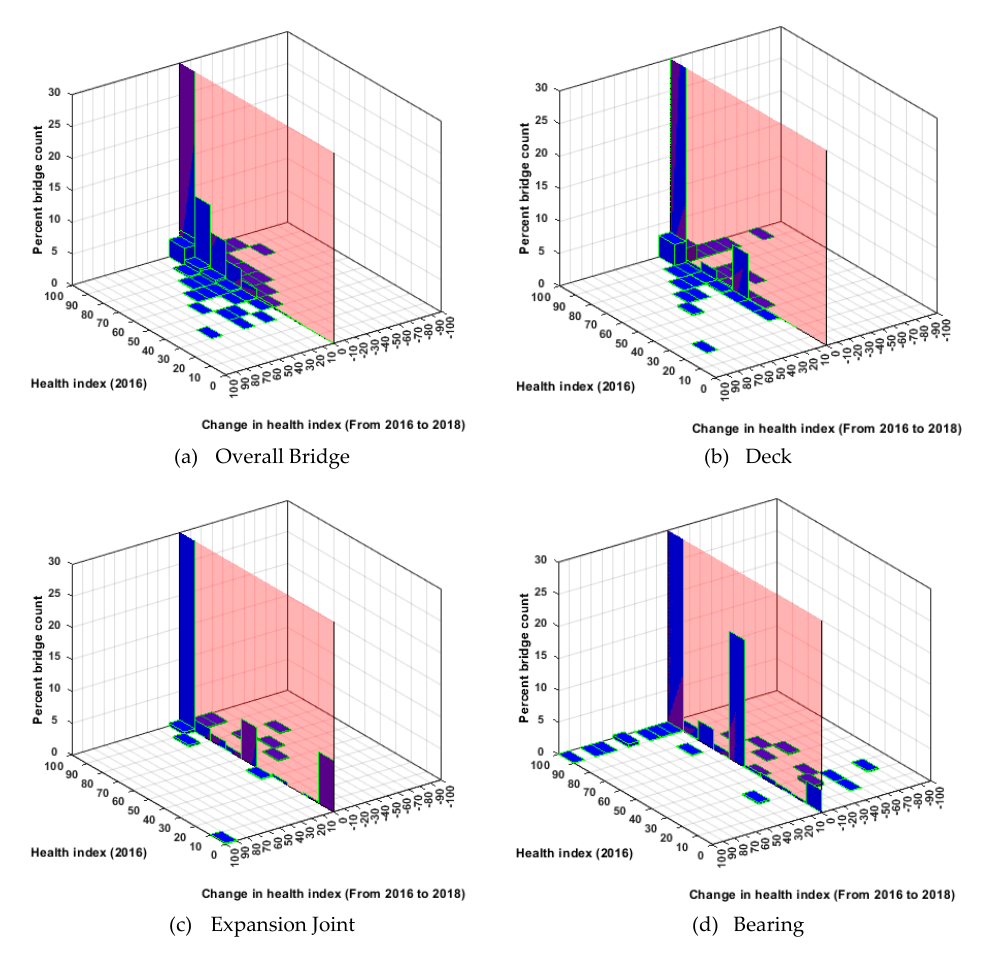
Figure 13. Non-NHS bridge performance in Pennsylvania. ( a ) Overall bridge; ( b ) concrete deck; ( c ) expansion joint; ( d ) bearing.